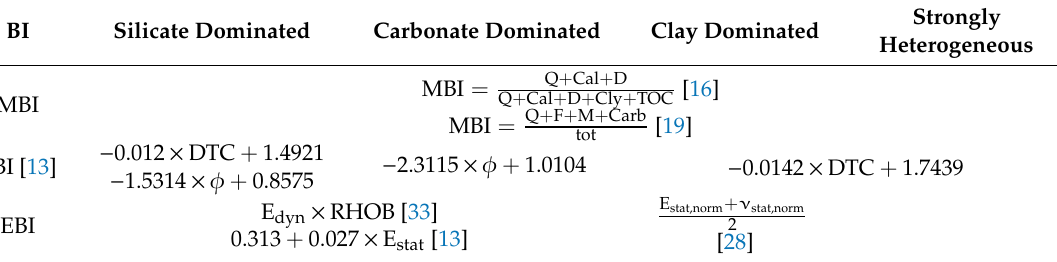
Table 5. Summary of MBI correlations based on the mineral